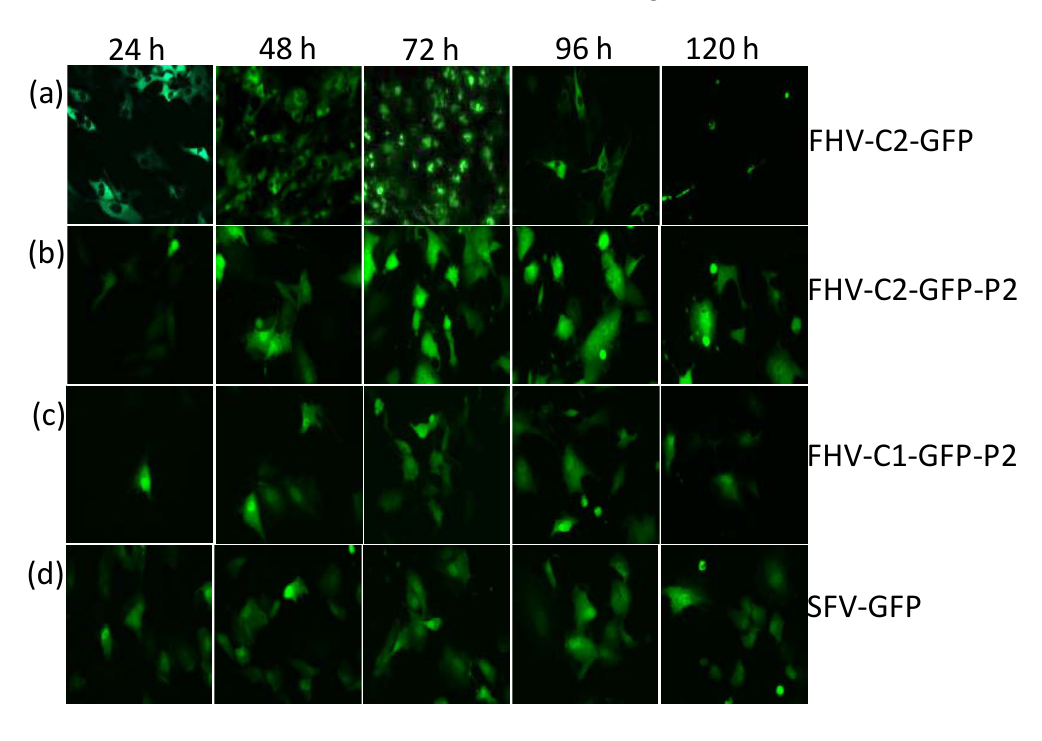
Figure 3. Time course assay observing daily fluorescence of different FHV GFP clones over a period of 120 h. BHK-21 cells were exposed to 2 µg of FHV RNA via liposome-mediated transfection, incubated at 28 °C and observed for fluorescence daily. All cell images are at a 400× magnification: ( a ) FHV-C2-GFP; ( b ) FHV-C1-GFP-P2A; ( c ) FHV-C2-GFP-P2A; and ( d ) FHV-C4-GFP-P2A and SFV-GFP. Images from expression vectors that had